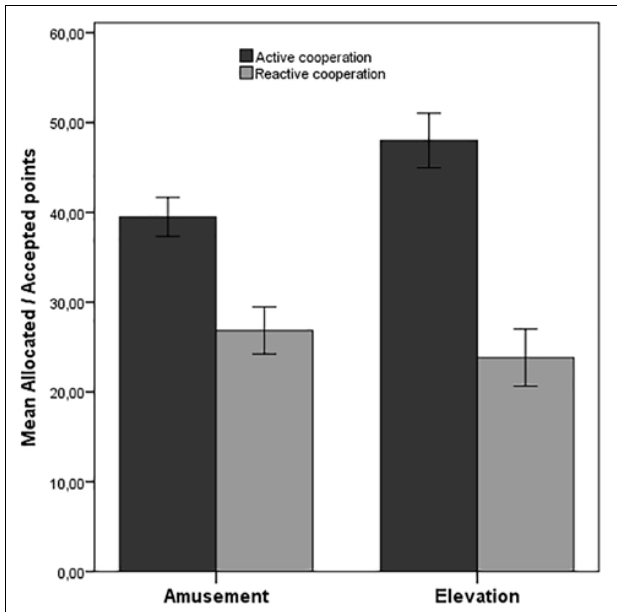
FIGURE 2 | Mean amounts of allocated points in the dictator game (active cooperation) and mean minimal accepted points in the ultimatum game (reactive cooperation). Error bars indicate standard errors. The results depicted are those using the trimmed sample; for dictator game: N = 116, for ultimatum game: N =